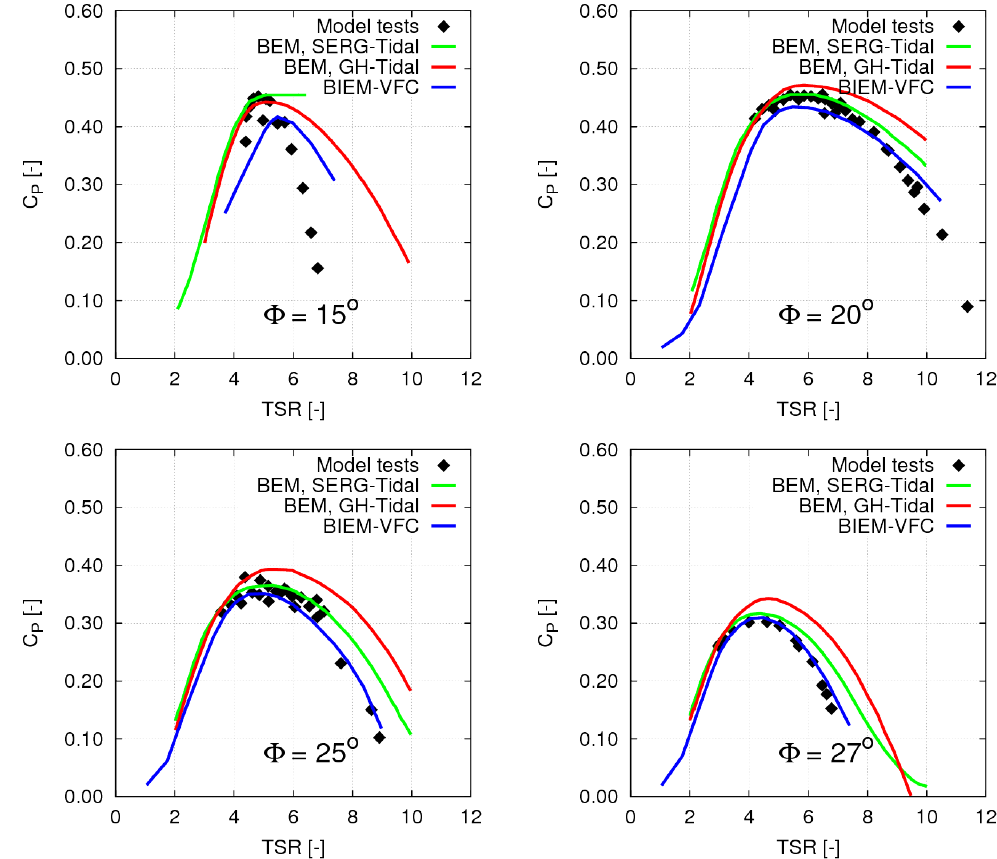
Figure 29. UoS-VP turbine performance predictions by BIEM-VFC compared to results of BEM models from [25]: power coefficient C . Pitch settings Φ = 15 ◦ to 27 ◦ . P